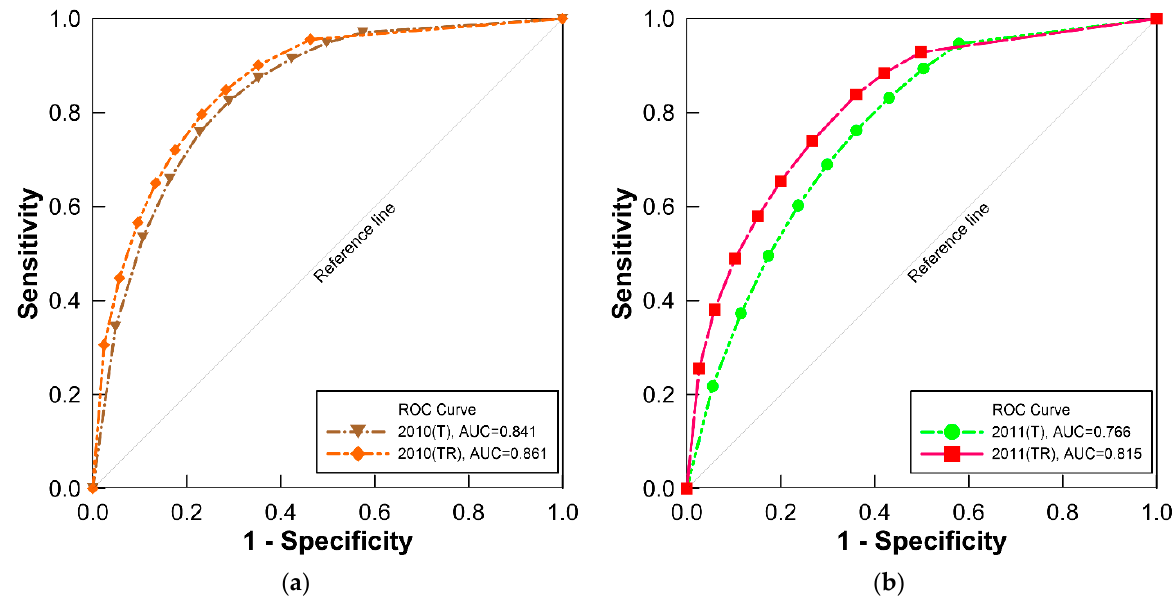
Figure 13. ROC curves of flood vulnerability and inundation traces for performance evaluation: ( a ) September 2010; ( b ) July 2011.